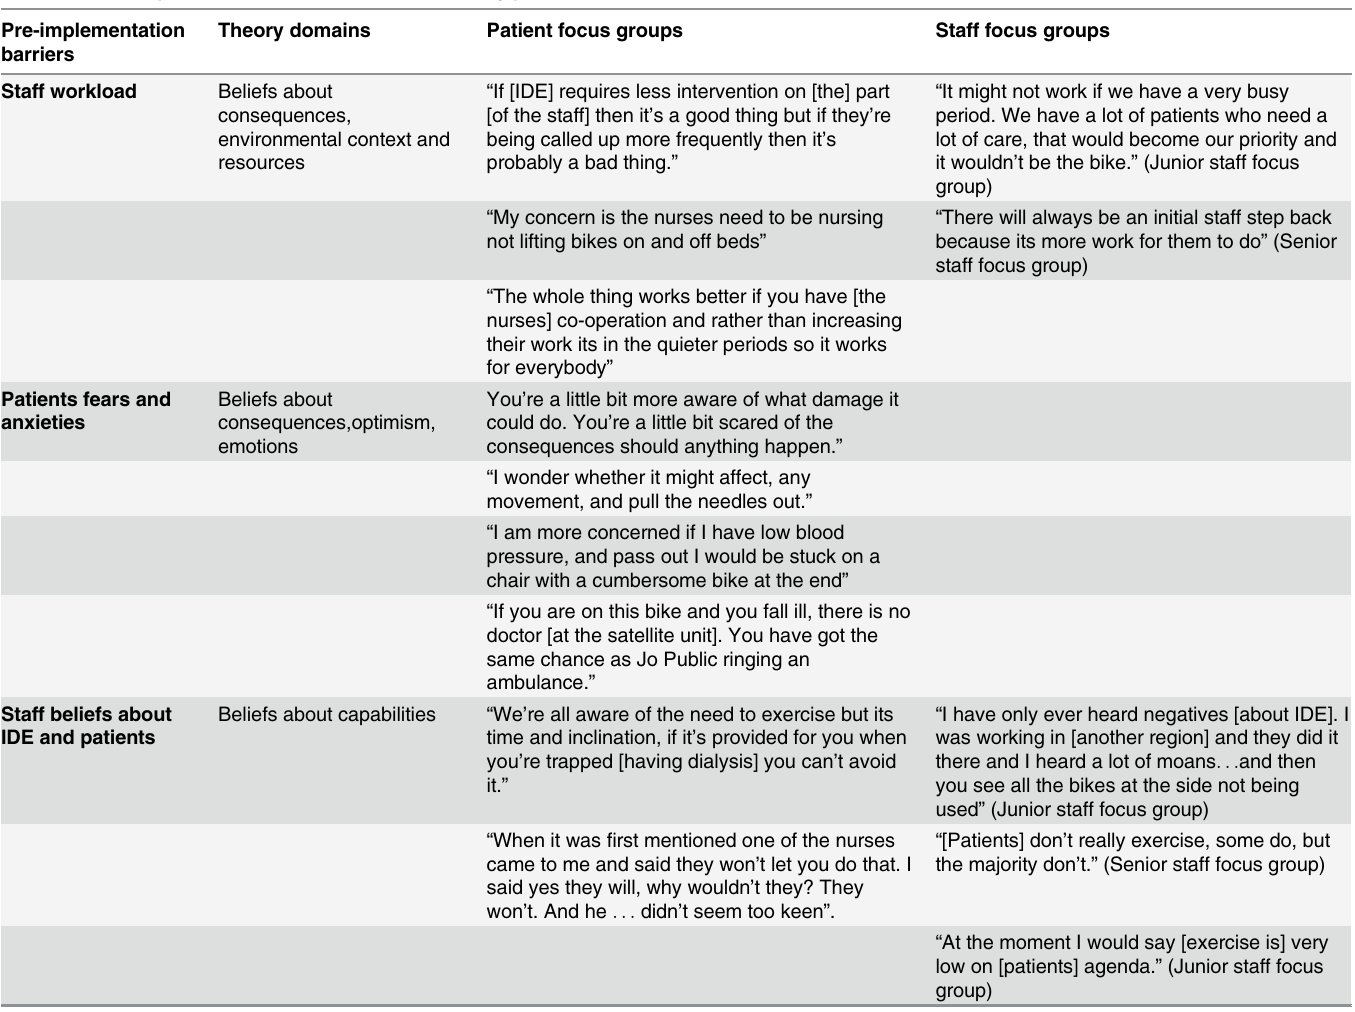
Table 2. Pre — implementation barriers, as identified by patients and